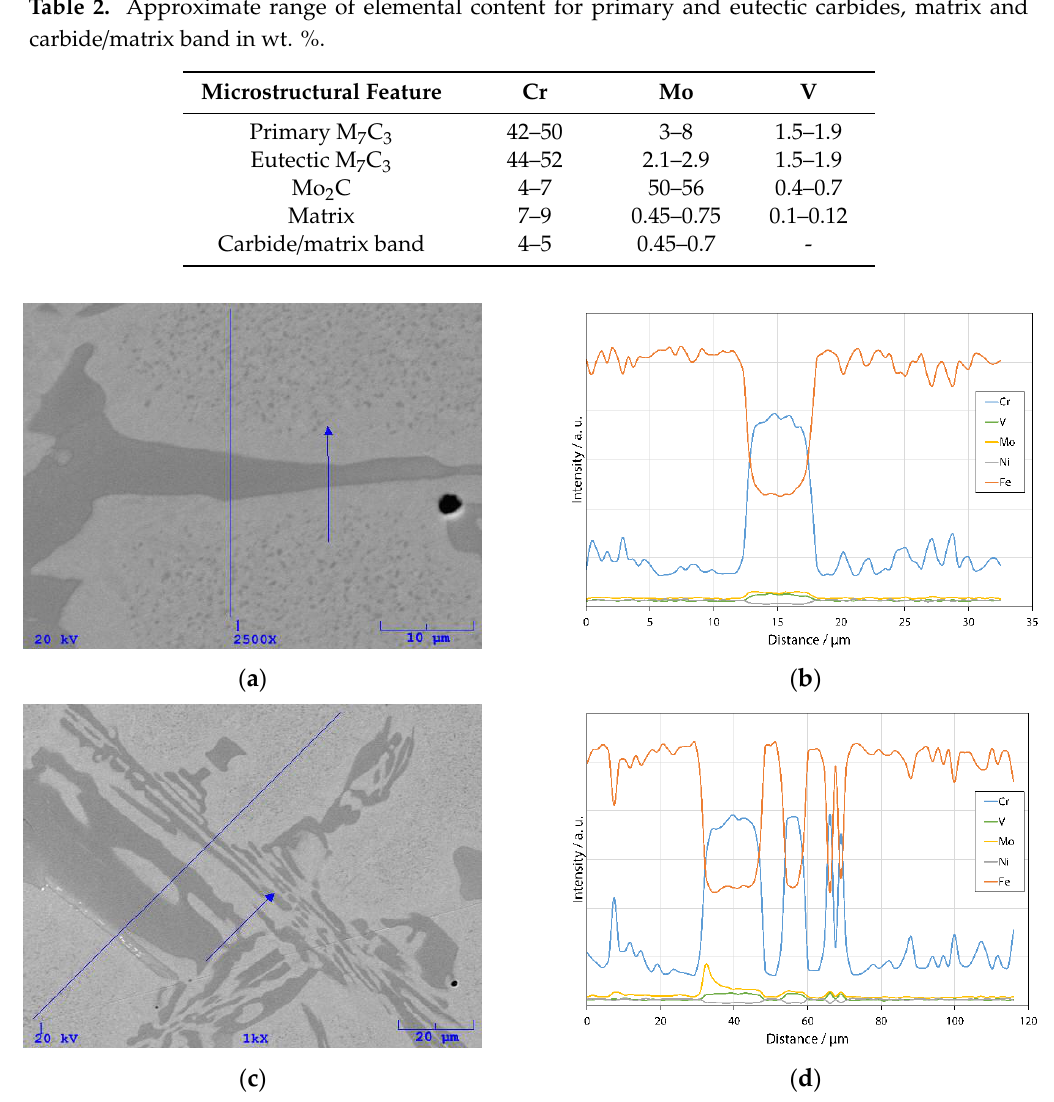
Figure 3. BSE micrograph and elemental line distributions of Cr, Mo, V, Ni and Fe in matrix and carbides: ( a ) primary carbides, ( b ) line distribution of elements across primary carbides, ( c ) eutectic carbides and ( d ) line distribution of elements across eutectic carbides.